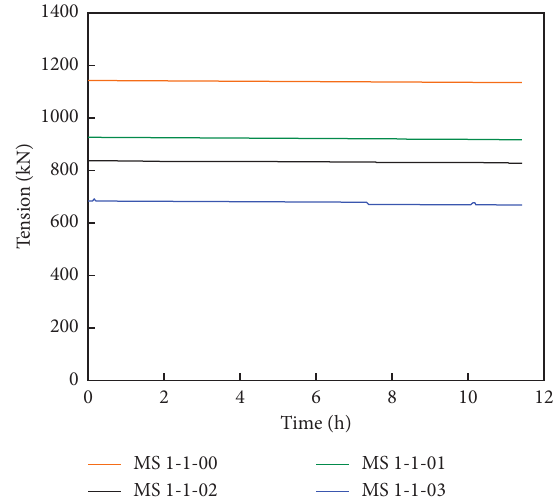
Figure 8: Test curve of the water pressure test process after soil filling by the magnetic flux sensor.